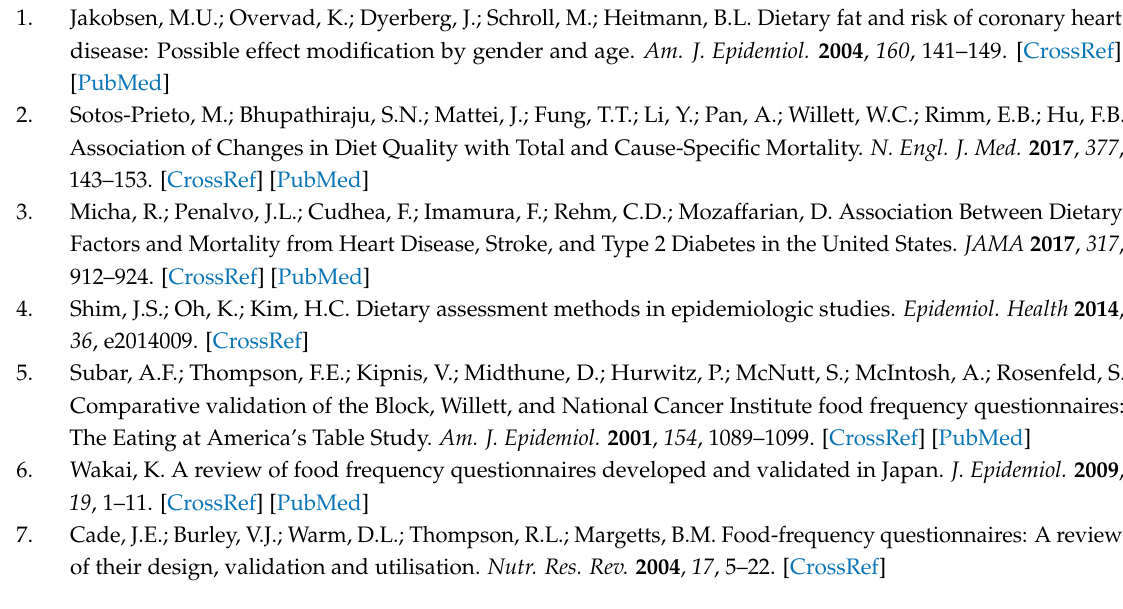
Table S1: Comparison of daily energy and nutrient intake based on dietary records or a short food frequency questionnaire according to age-stratified groups in men, Table S2: Comparison of daily energy and nutrient intake based on dietary records or a short food frequency questionnaire according to age-stratified groups in women, Table S3: The coefficients of variation, and within- to between-person variance ratios of energy and nutrient intake based on dietary record (DR), shown per sex, Table S4: Group size required to ensure accuracy of energy and nutrients intake with 95% confidence interval (CI) within the specified % deviation (D 0 ) of a group’s mean from the group’s usual (“true”) mean intake based on dietary record (DR), shown per sex, Table S5: Number of days required to ensure precision of energy and nutrients intake within specified correlation coefficient ( r ) between observed and usual (“true”) mean intake based on dietary record (DR), shown per sex, Table S6: Number of days required to ensure accuracy of energy and nutrients intake with 95% confidence interval (CI) within the specified % deviation (D 1 ) of an individual’s usual (“true”) mean intake based on dietary record (DR), shown per